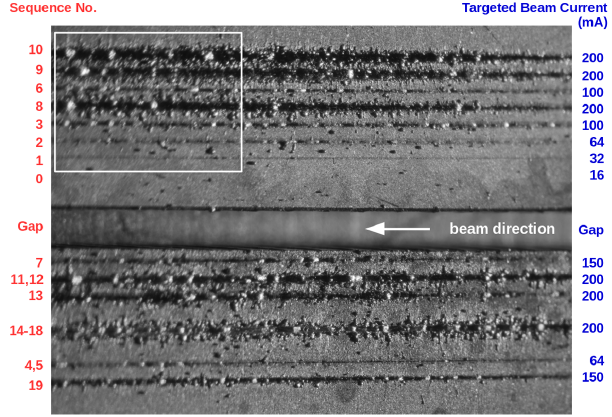
FIG. 22. Photograph of the January 2020 collimator test pieces still attached to the scraper body. Sequence numbers are shown on the left; targeted currents are listed on the right. “ Targeted ” refers to nominal current we were intending to store before the beam was dumped. The actual currents are given in Table VI. The gap between upper and lower collimator pieces is 0.83 mm. The pieces were positioned at x ¼ − 2 mm prior to dumping the beam by rf muting.